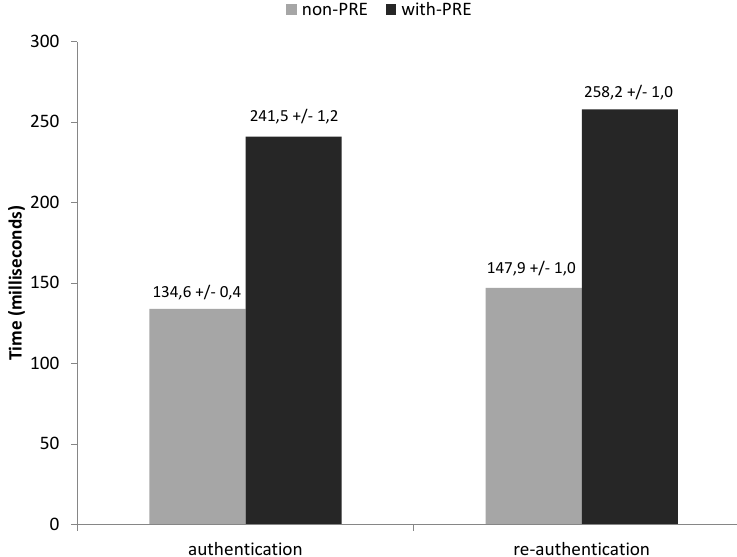
Figure 7. Total mean authentication and re-authentication